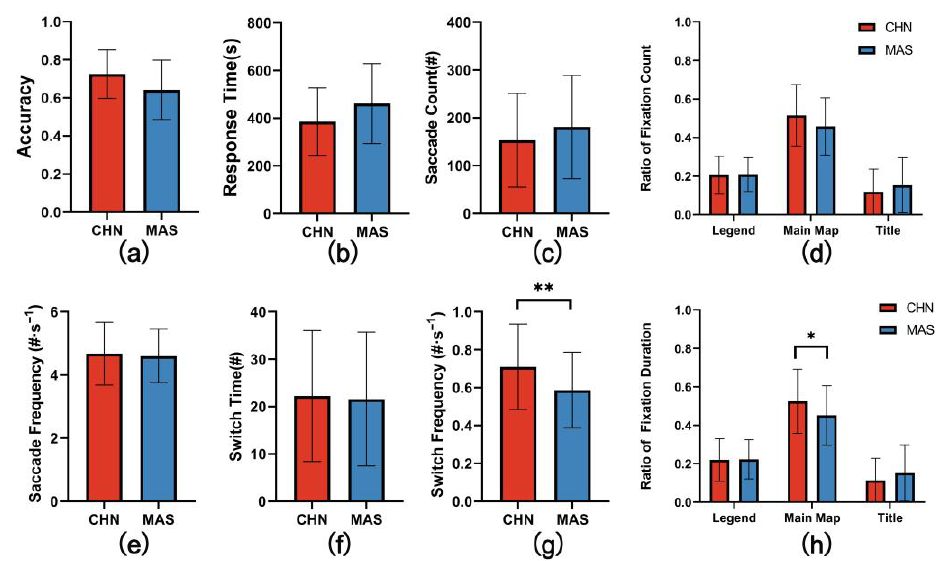
Figure 7. Statistics in the spatial correlation task: ( a ) accuracy; ( b ) response time; ( c ) saccade count; ( d ) ratio of fixation count; ( e ) saccade frequency; ( f ) switch time; ( g ) switch frequency; ( h ) ratio of fixation duration (* p < 0.05, ** p < 0.01).